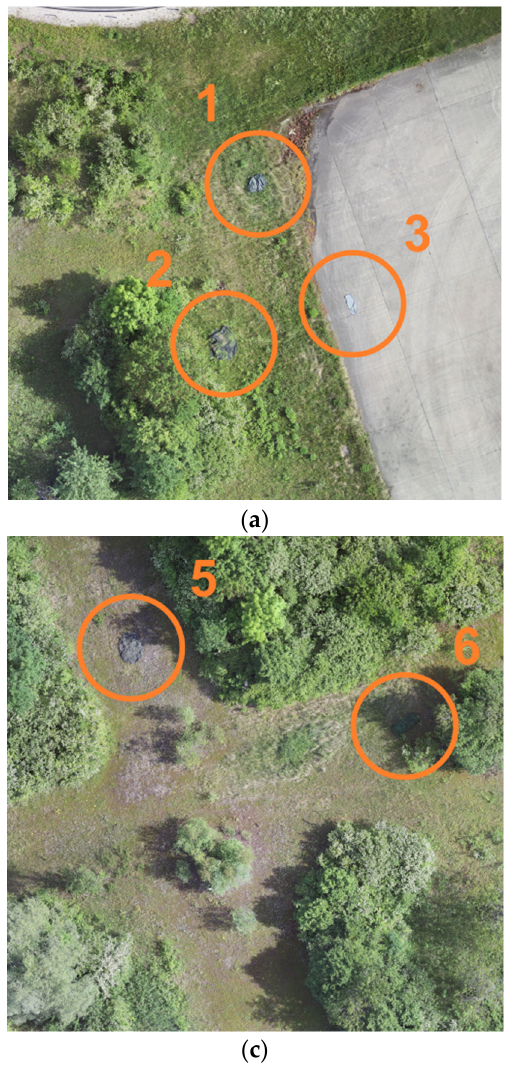
Figure 3. All camouflaged targets of MUCAD in their visual band. ( a ) Green tarpaulin (1), 2D camouflage net (2), and gray tarpaulin (3); ( b ) artificial grass mat (4); ( c ) 3D camouflage net (5), and artificial hedge (6); ( d ) two persons wearing a battle dress uniform and a German field dress, respectively, (7) and two gray cars (8).